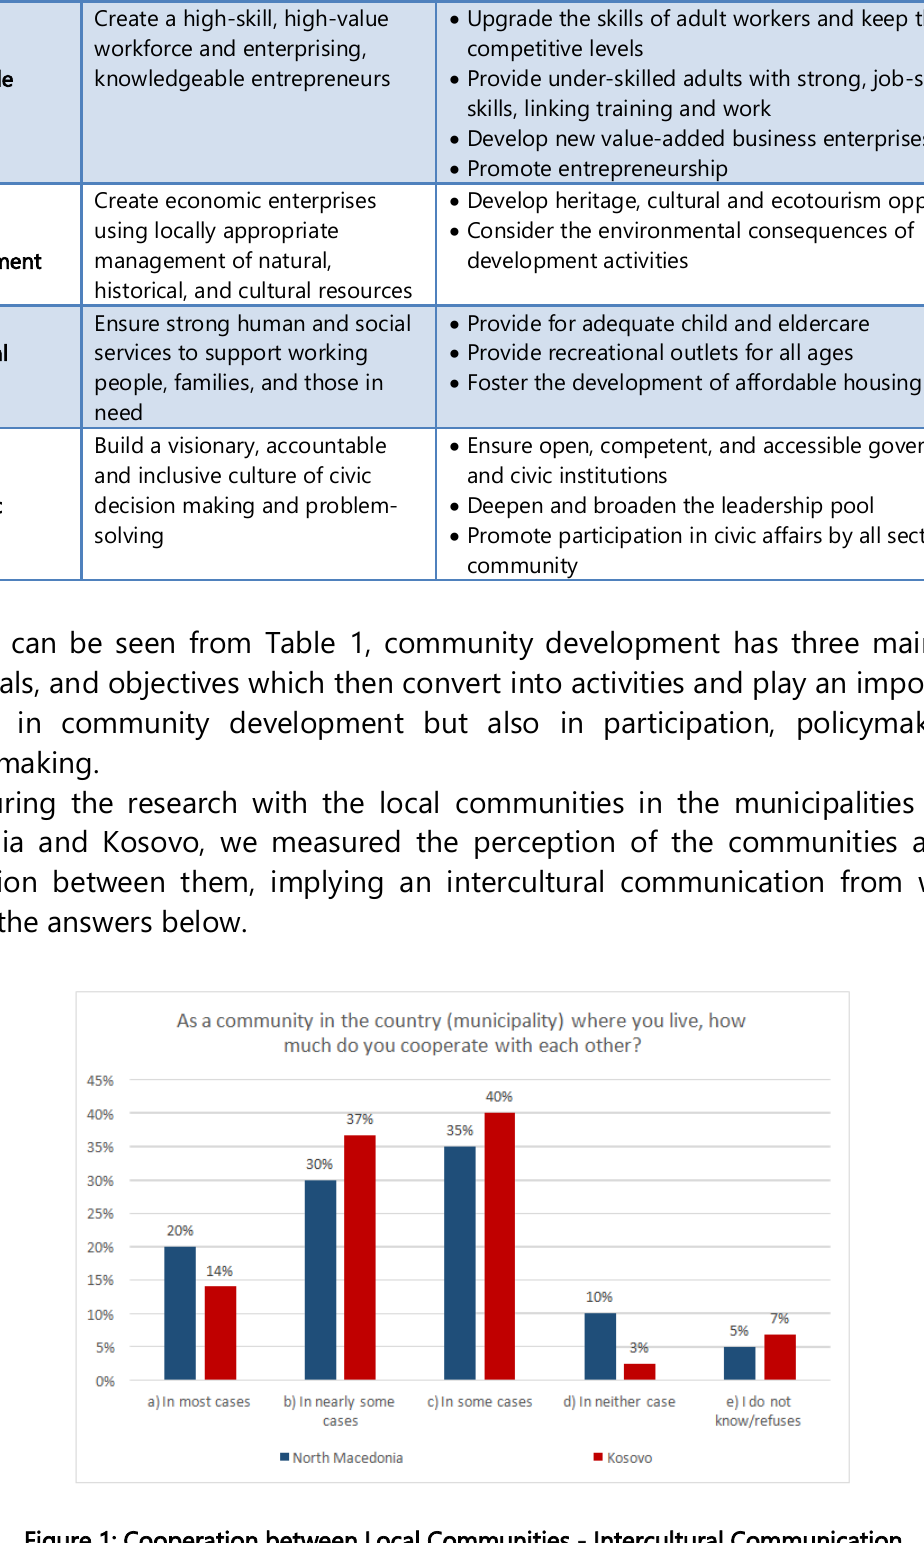
Figure 1: Cooperation between Local Communities - Intercultural Communication (Source: Kamberi and Vejseli